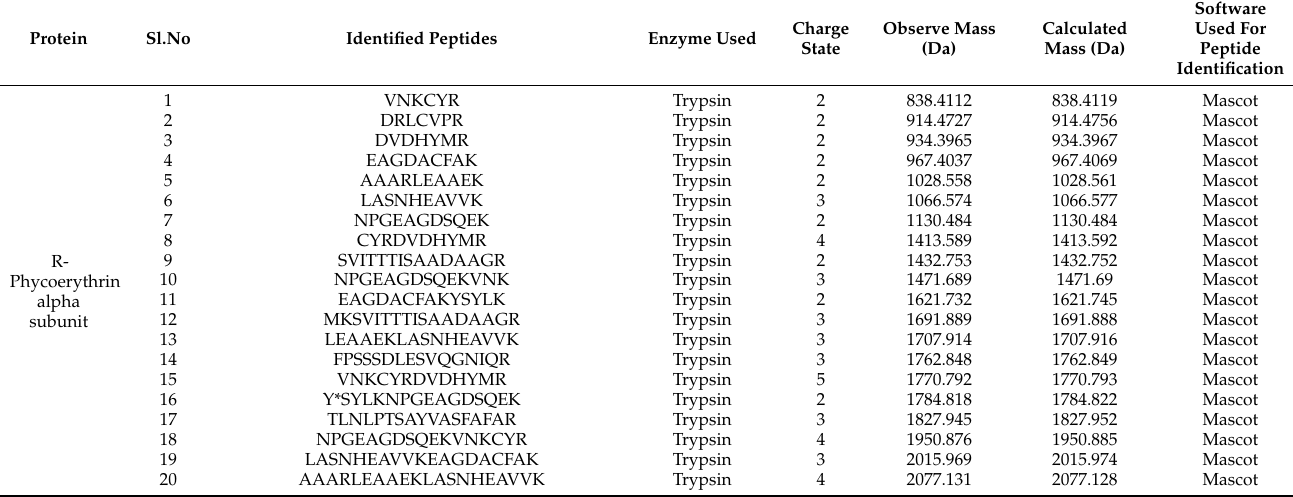
Figure 4. Peptide profile image of R-phycoerythrin alpha subunit. Table 1. Identified peptide list of R-phycoerythrin alpha